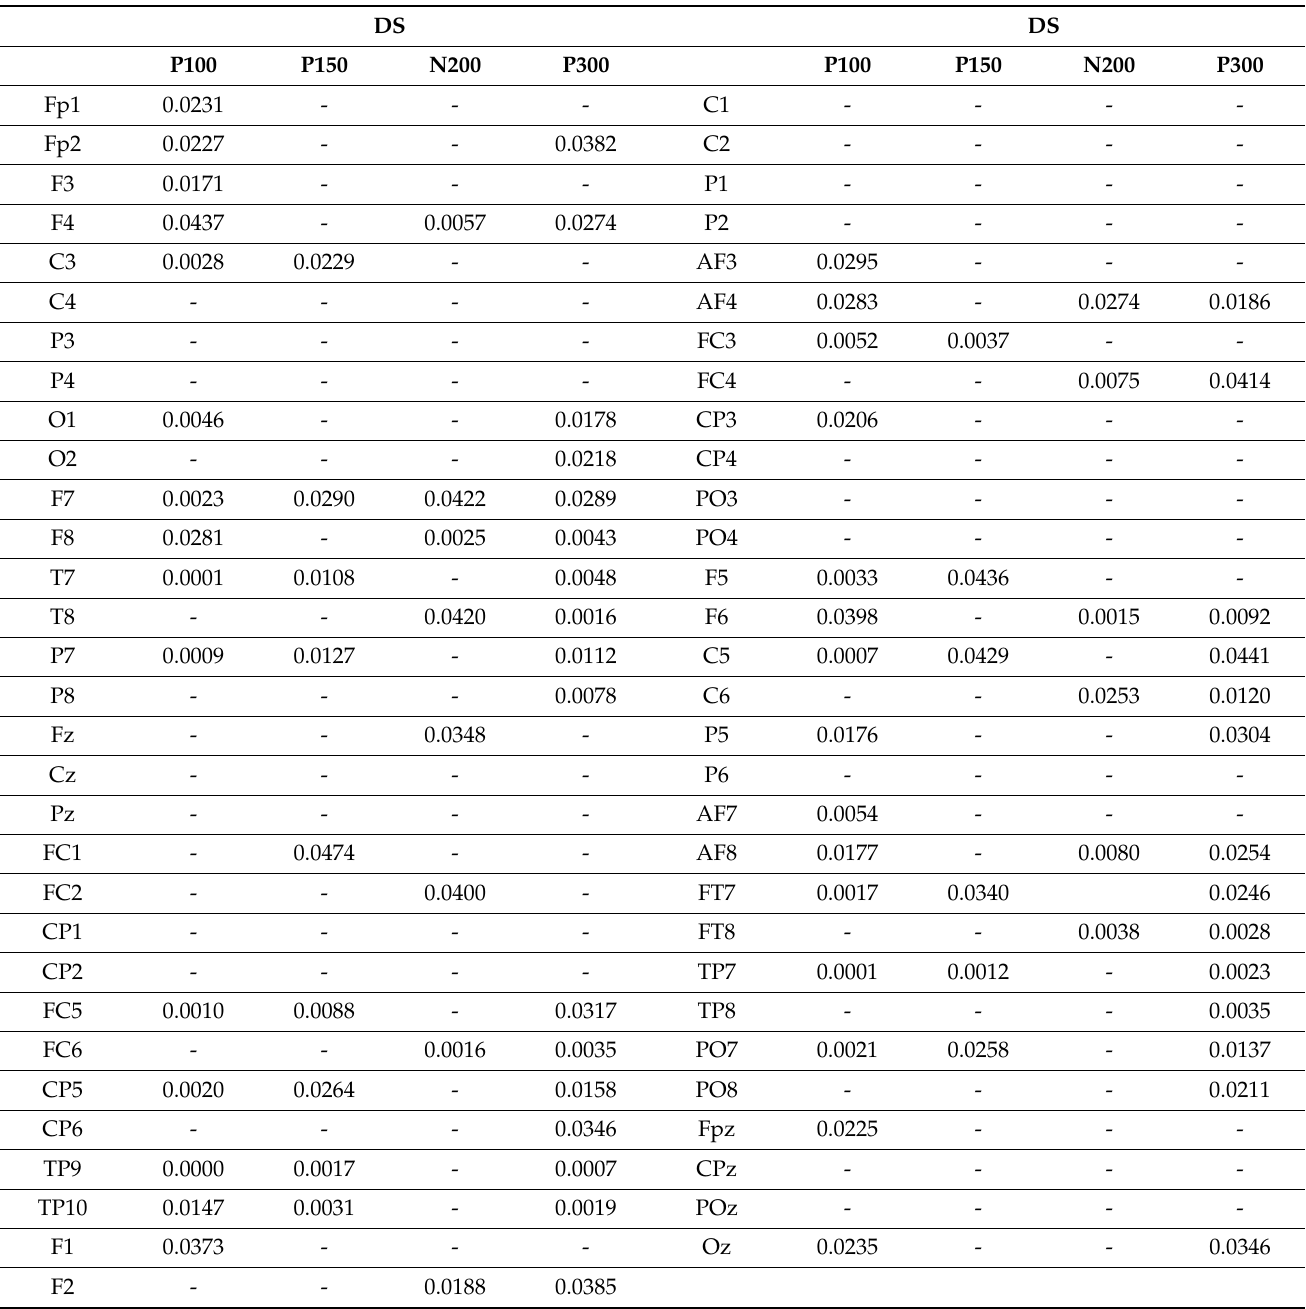
Table 2. Significant values ( p < 0.05) related to all electrodes for P100, P150, N200 and P300 for the go stimulus in the directional (DS) condition between the fast (F) and slow (S) groups; “-“ indicates non-significant results. The results were corrected using the FDR method to resolve the issue of multiple